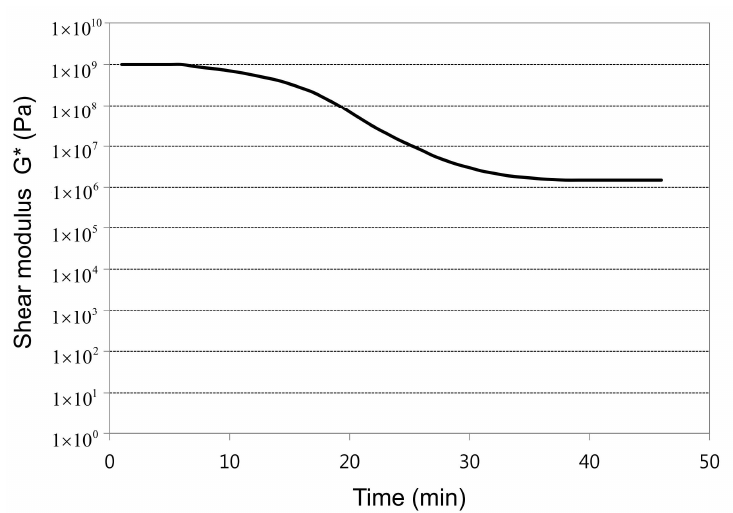
Figure 4. Stress relaxation of silicone